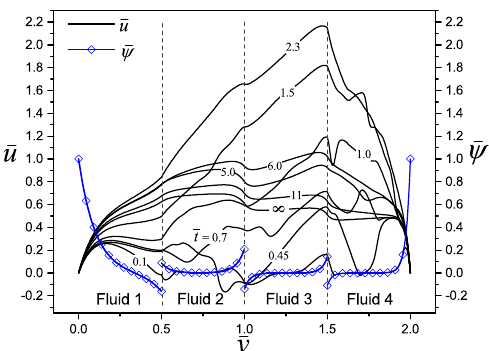
Figure 7. Dimensionless electric potential and velocity profiles of an electroosmotic flow with n = 4, ( ¯ y 1 = 2/3, ¯ y 2 = 1, ¯ y 3 = 3/2 ), ¯ κ 1 = 10, ¯ κ 2 = 20, ¯ κ 3 = 30, ¯ κ 4 = 40, ¯ ρ n = ¯ (cid:101) n = 1, ¯ λ 1 = 0.1, ¯ λ 2 = 2, ¯ λ 3 = 1, ¯ λ = 10, ∆ ¯ ψ = 0.25, ∆ ¯ ψ = − 0.35, ∆ ¯ ψ = − 0.25, and ¯ η n = 2 . 2 3 4 1